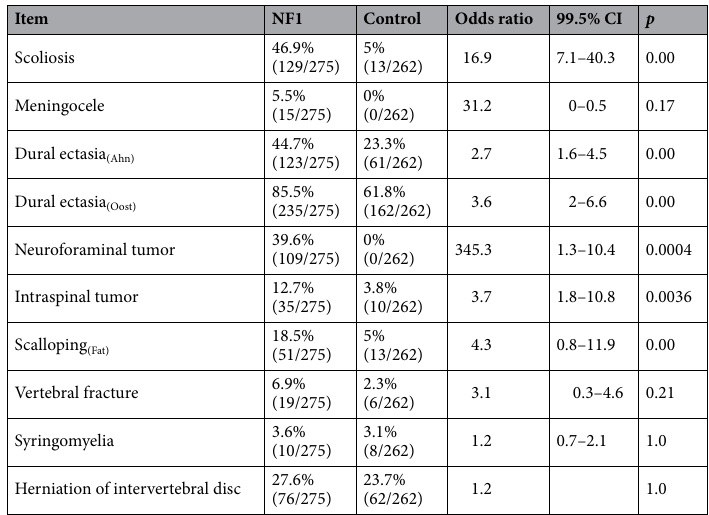
Table 1. Spinal abnormalities in NF1 patients and the control group. Presented are prevalence and association of spinal abnormalities with NF1. Due to Bonferroni adjustment for multiple testing, adjusted p-values and 99.5% confidence intervals are reported. Values in parentheses are total numbers. CI confidence interval.